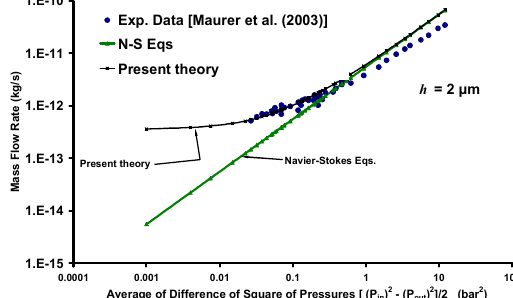
Fig. 6: Comparison of mass flow rate as a function of composite pressure drop (difference in squares of pressures), for helium, against the experimental data of Maurer et al.